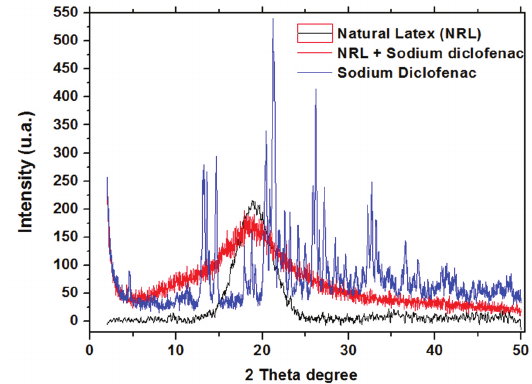
Figure 3. Sodium diclofenac release as a function of time for the NRL membrane. Notice that the diclofenac concentration reaches a plateau after approximately 74 hours. Each point refers to triplicate measurement.